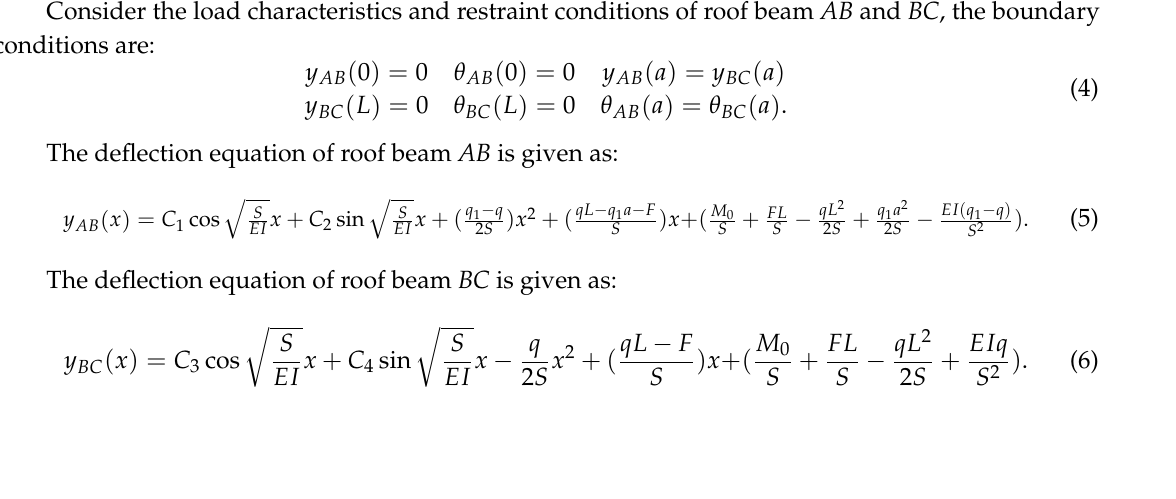
Figure 2. Mechanical model of the roof beam.